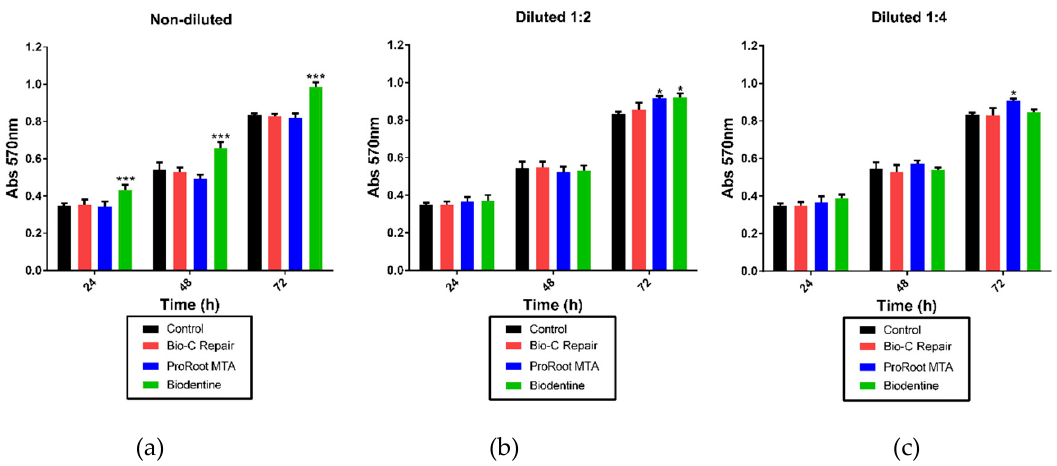
Figure 4. Relative formazan formation of hDPCs that were exposed to Biodentine, ProRoot MTA, and Bio-C Repair eluates, as well as the culture medium (control) for 24, 48, and 72 h. ( a ): Non–diluted, ( b ) Diluted 1:2, ( c ) Diluted 1:4. The bar heights represent the mean values and the line extensions represent the standard deviations. Significant differences compared to the control are marked with an *, where * means p < 0.05, and *** means p < 0.001.